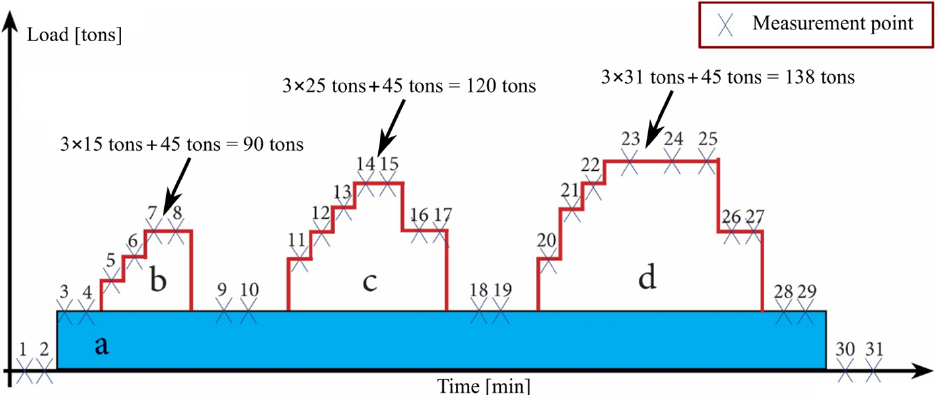
Figure 5. The loading scheme used in the case study with four loading phases. Phase (a) involves the fixed load of vehicle B, while the three following phases (b–d) concern vehicle A.